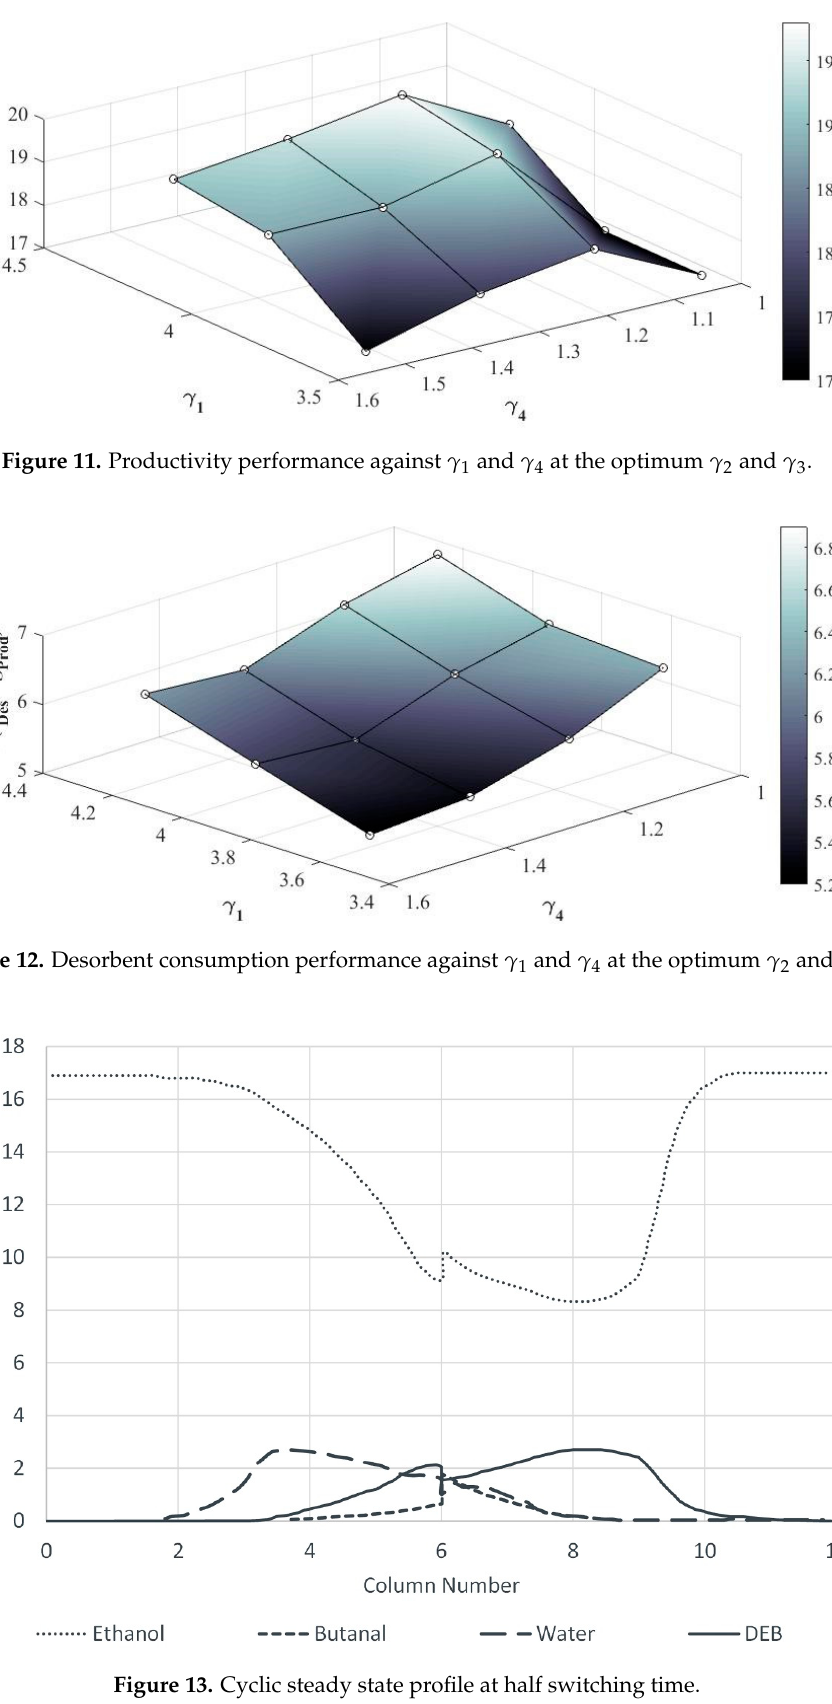
Figure 13. Cyclic steady state profile at half switching time.